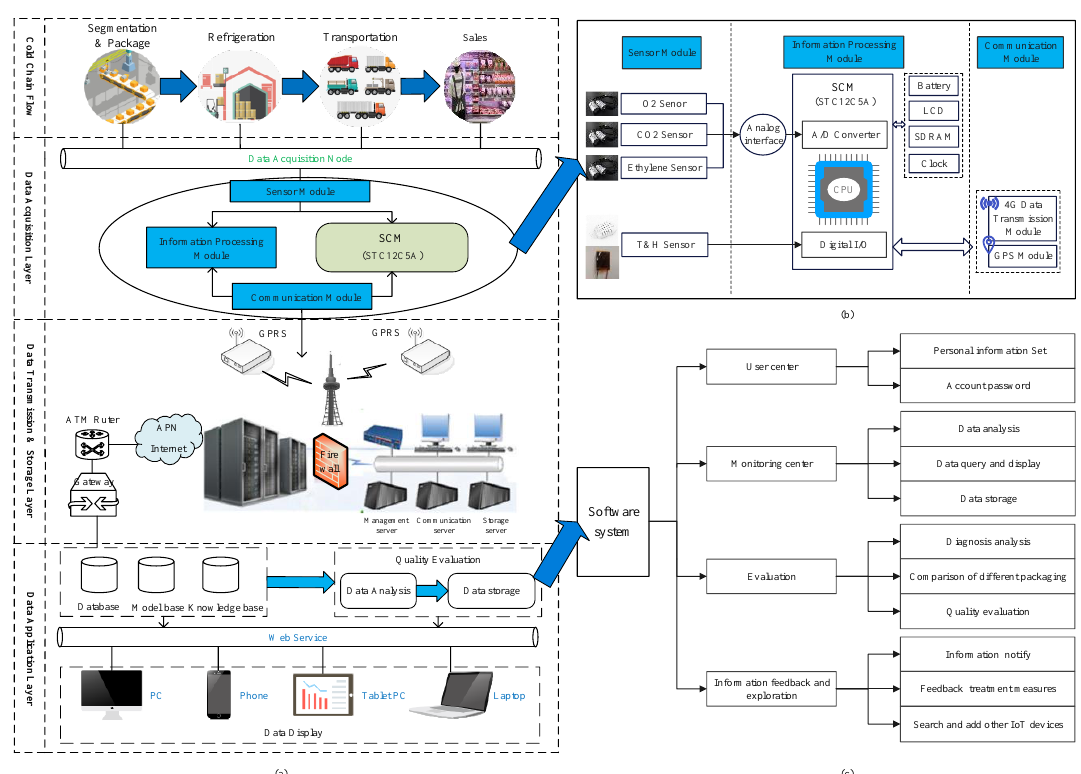
Figure 3. ( a ) The overall structure of the matsutake cold chain monitoring and tracing system; ( b ) the design of the hardware system structure; ( c ) the design of the software system structure.